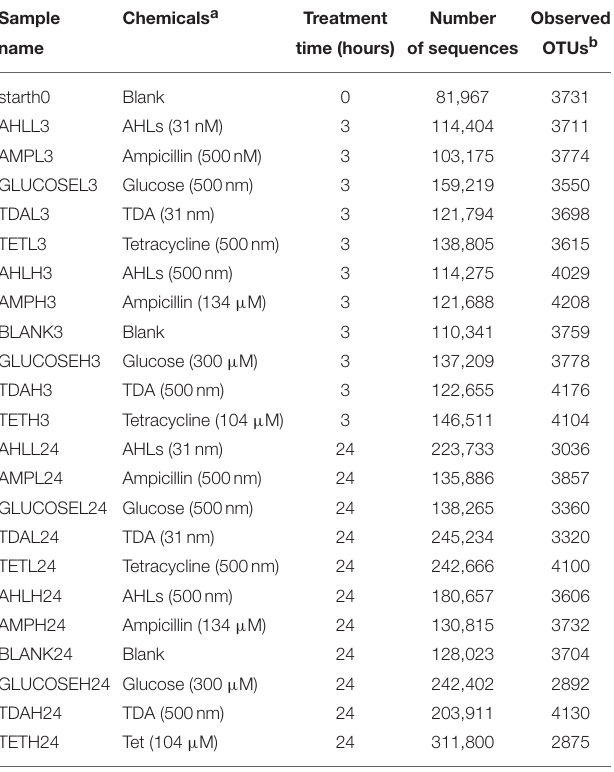
TABLE 1 | Chemical treatments in algal